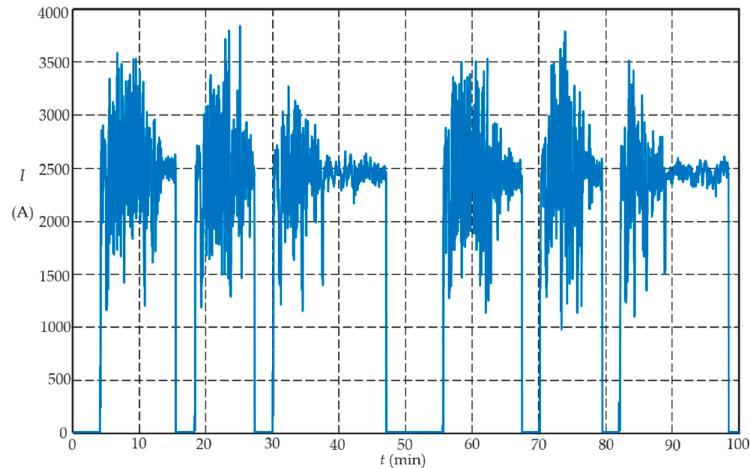
Figure 2. Fragment of the furnace current (1 s RMS) measured at 30 kV.